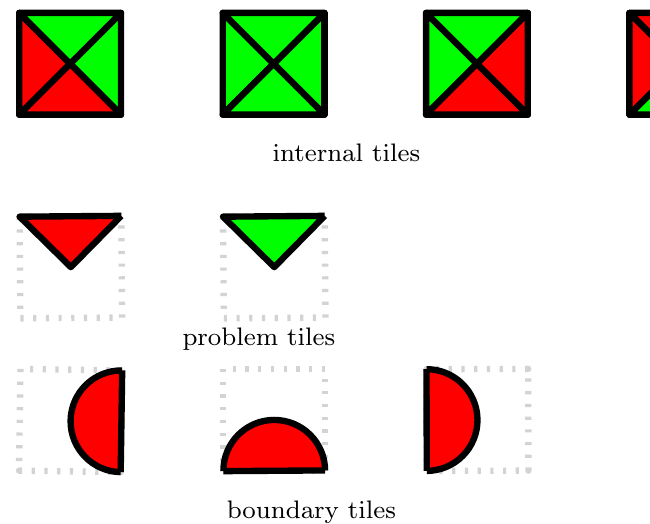
Figure 3. The set of the good